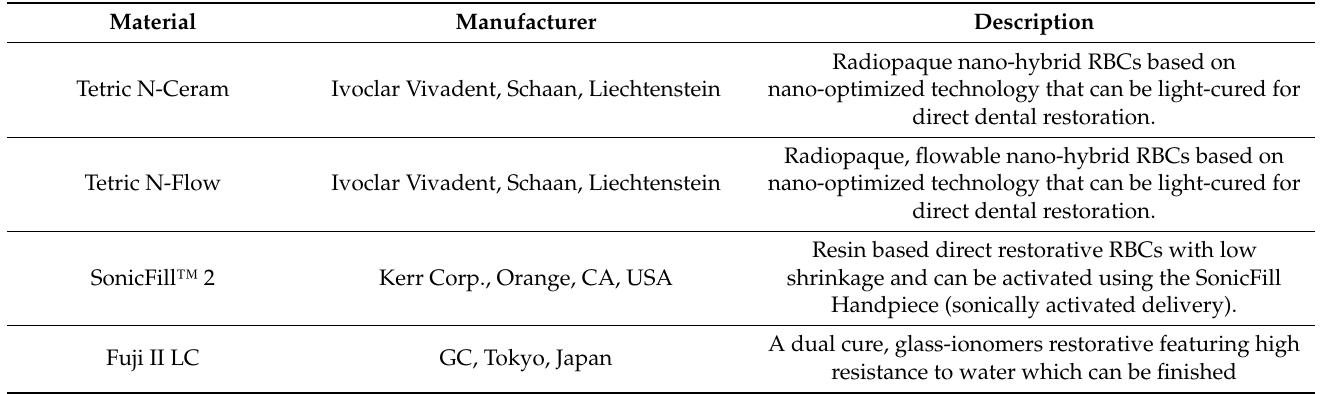
Table 1. Details of various restorative materials used in the study.